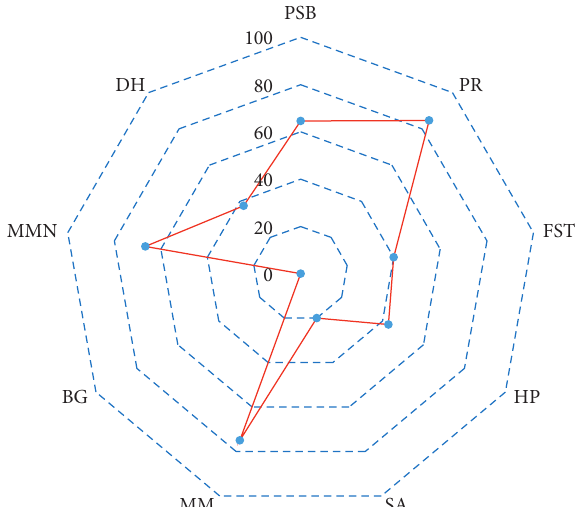
Figure 7: Rate of woody taxa debarked per green space. Prefecture garden (HP), Saint-Anne garden (SA), Blanche Gomes garden (BG),